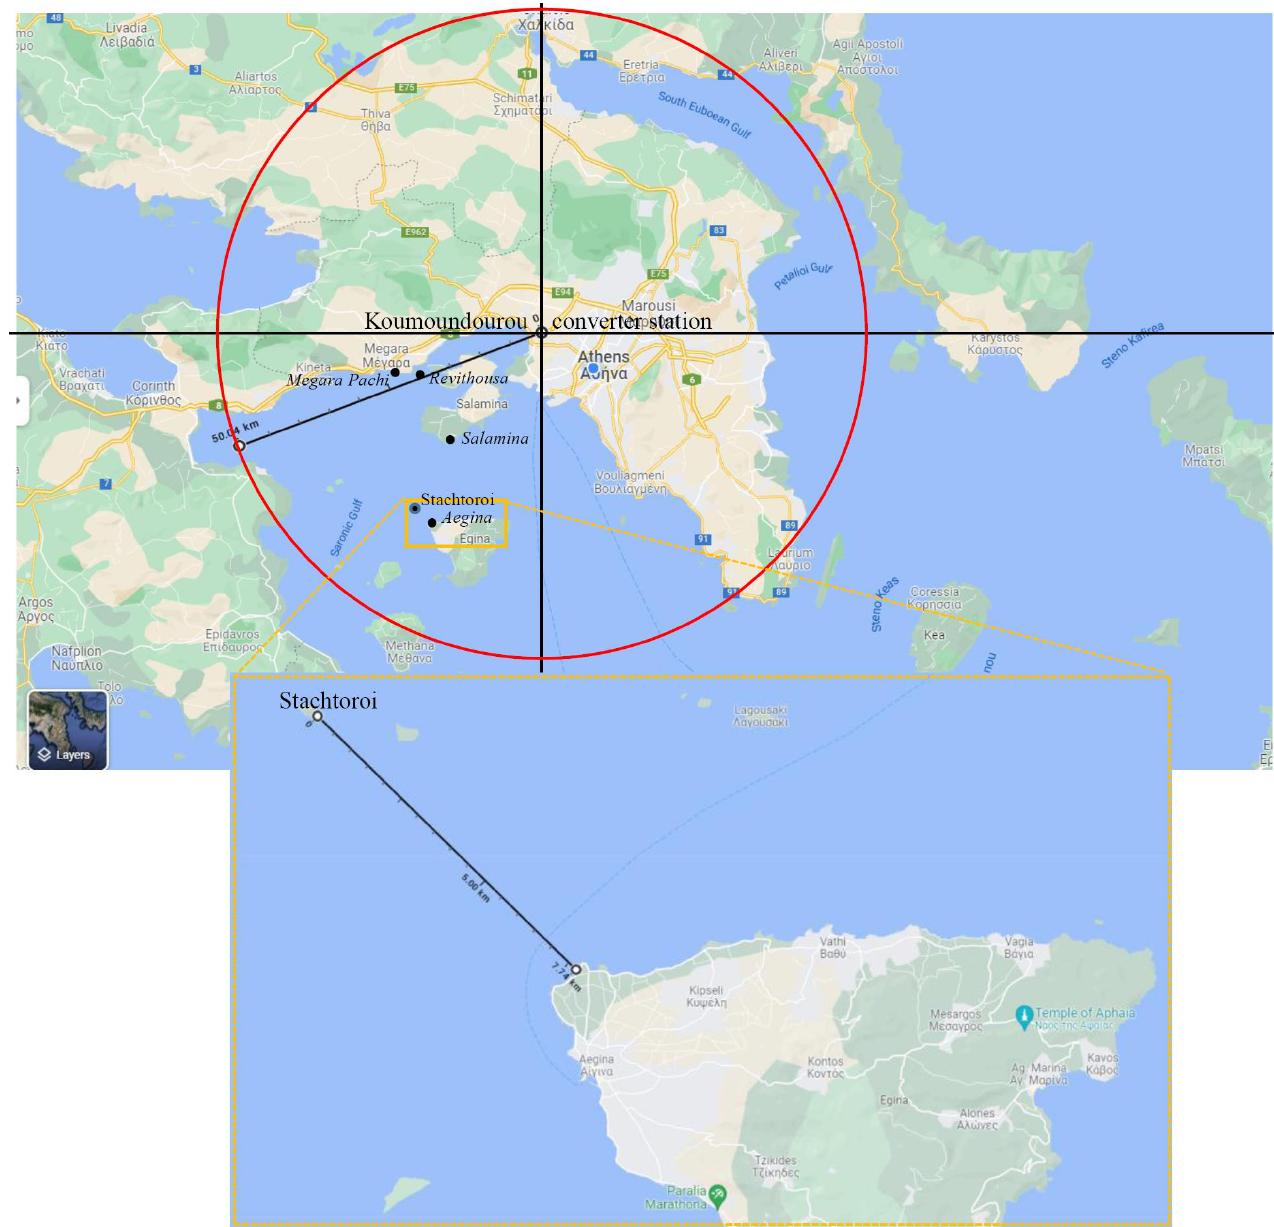
Figure 2. Location of the electrode station for an HVDC transmission system in the region of Attica– Stachtoroi (with italics are the nearby residential areas under